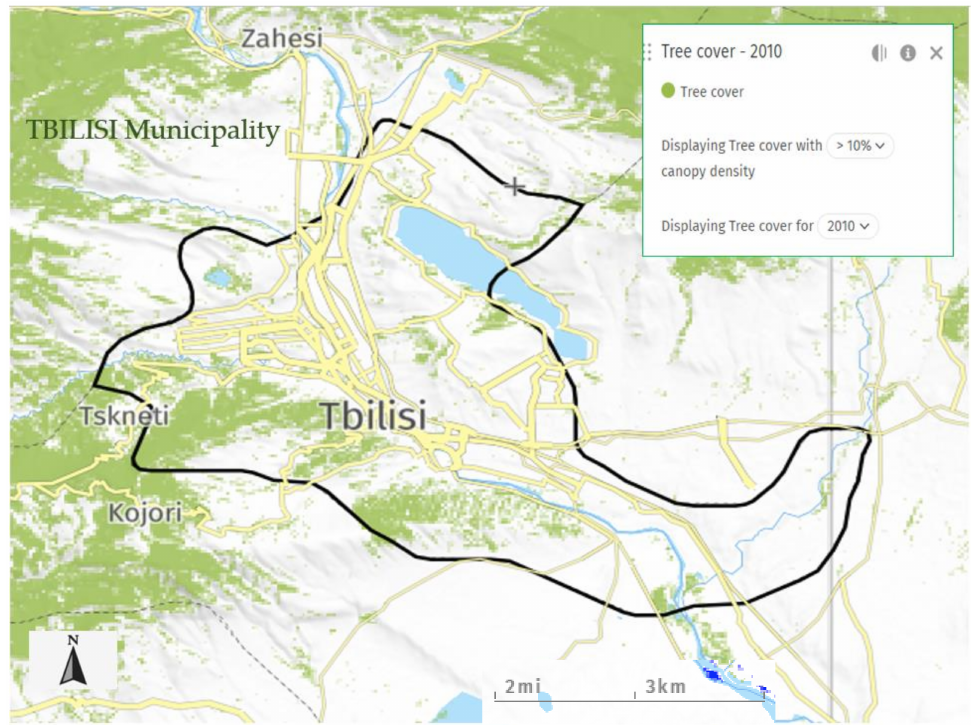
Figure 3. Map of Tbilisi Municipality, displaying tree cover with 10% and higher canopy density (Lat. Lon.: 41.70493, 44.76485, zoom: 10.48) (source: https://www.globalforestwatch.org/, accessed on 23 November 2022)